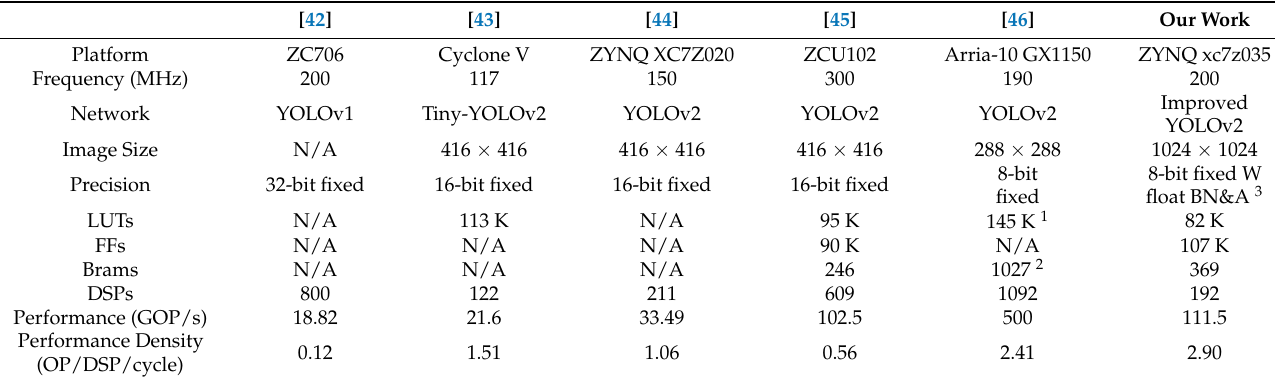
Table 4. The performance comparison of our design and those of previous